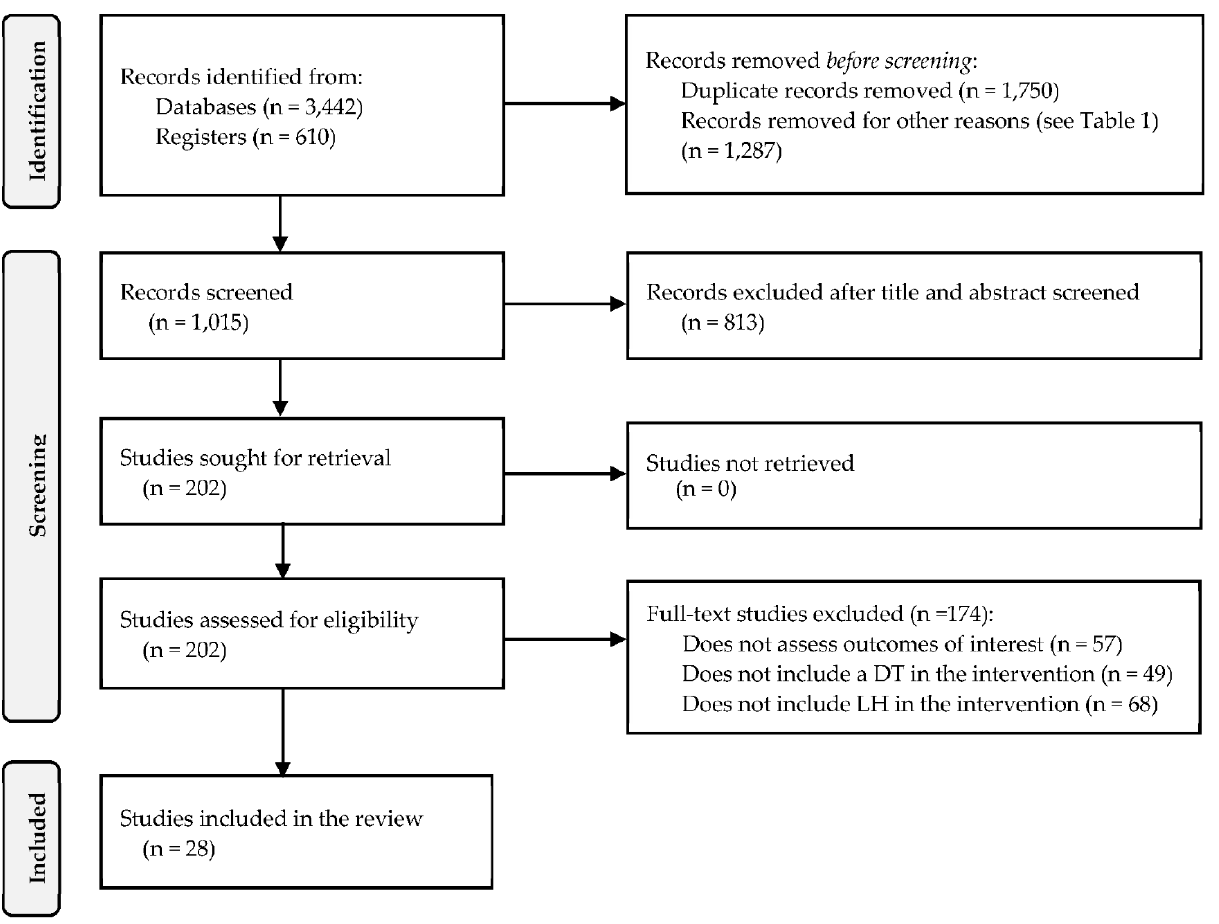
Figure 1. PRISMA flow chart.